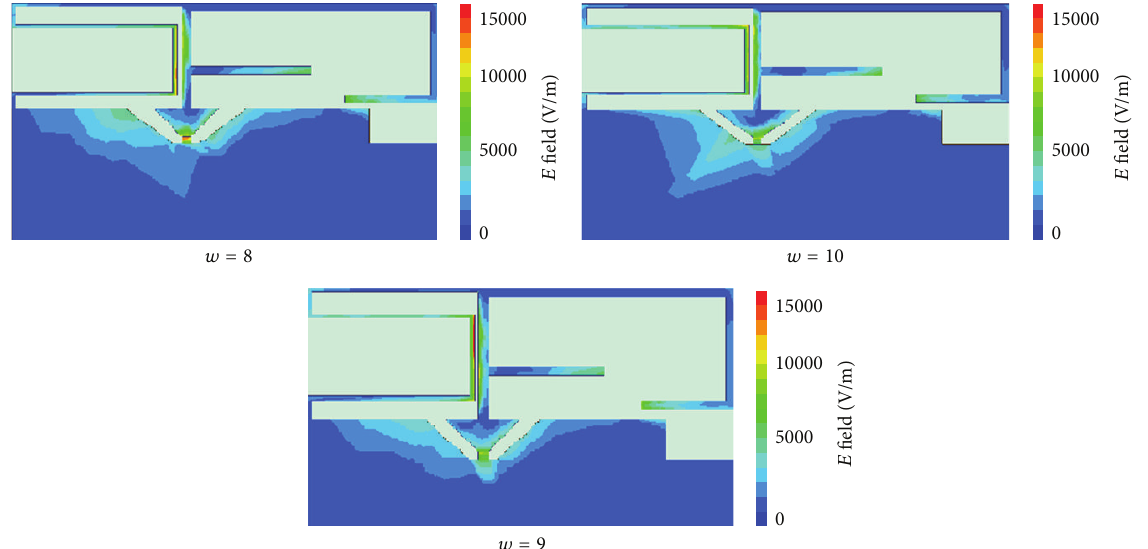
Figure 4: 𝐸 -field distributions at 2000 MHz (unit: mm).